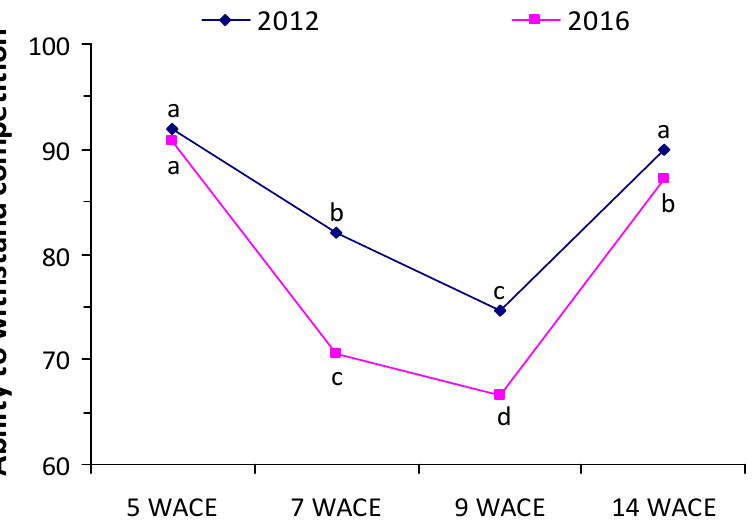
Figure 6. Ability to withstand competition (AWC) index at various weeks after crop emergence (WACE) in the first and second growing seasons. Different letters in each growing season indicate statistically significant differences at p < 0.05.